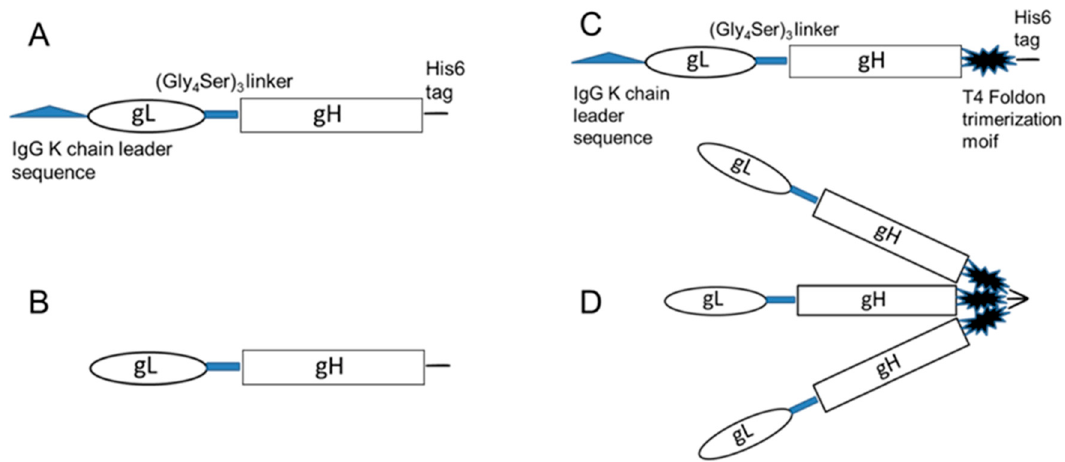
Figure 1. DNA constructs encoding human cytomegalovirus (HCMV) monomeric and trimeric gH / gL. ( A ) Diagram of the DNA sequences for production of monomeric HCMV gH / gL. ( B ) Diagram of recombinant HCMV monomeric gH / gL protein. ( C ) Diagram of the DNA sequences for the production of HCMV trimeric gH / gL. ( D ) Diagram of recombinant HCMV trimeric gH / gL protein.